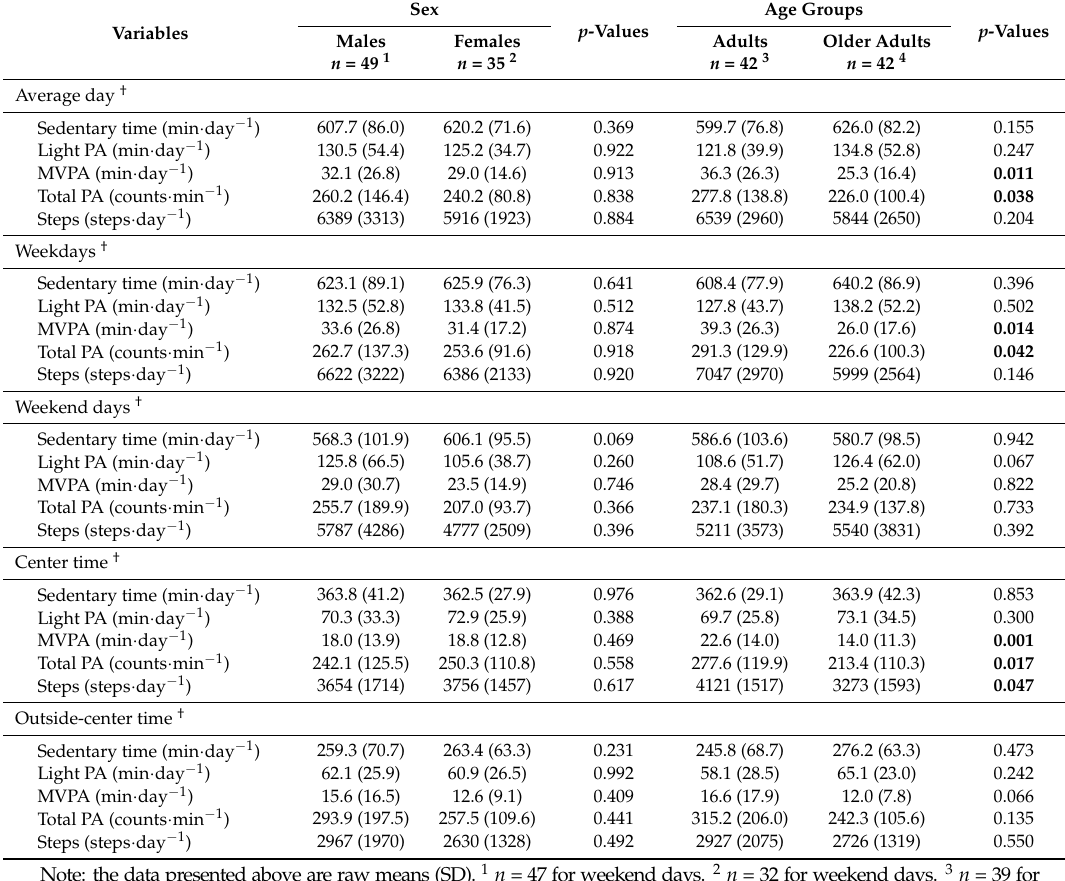
Table 3. Patterns of sedentary time and physical activity throughout the week in adults and older adults with ID by sex and